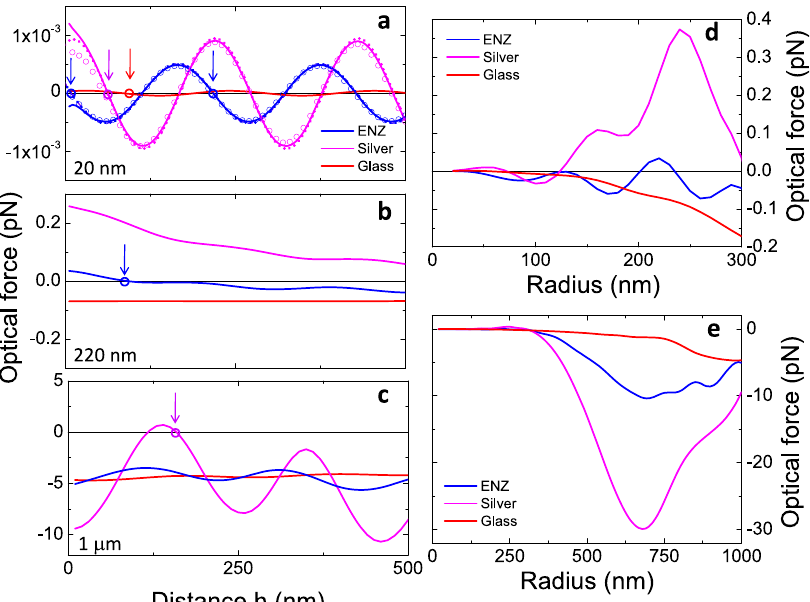
Fig. 2 Total optical force in front of ENZ, silver, and glass surfaces. Total optical force as a function of edge-to-edge distance, h , for polystyrene particles of different size: a a = 20 nm), b a = 220 nm, and c a = 1 μ m. Different approaches for the calculation of the force are compared: dipole approximation (short dots), COMSOL (circles) and T-matrix (continuous lines). Different surfaces, glass (red), silver (magenta), ENZ (blue), yield very different optomechanical interactions in terms of force amplitude, modulation with respect to h , and phase shifts. Arrows indicate self-binding points, where particles are stably trapped in front of the surface. d , e Size dependence of the total optical force for fi xed edge-to-edge distance, h = 10 nm. For small particles the gradient force component of the partially re fl ected plane wave dominates, resulting in a dependence with particle size, while for large particles radiation pressure has a major contribution resulting in a negative force pushing the particle towards the